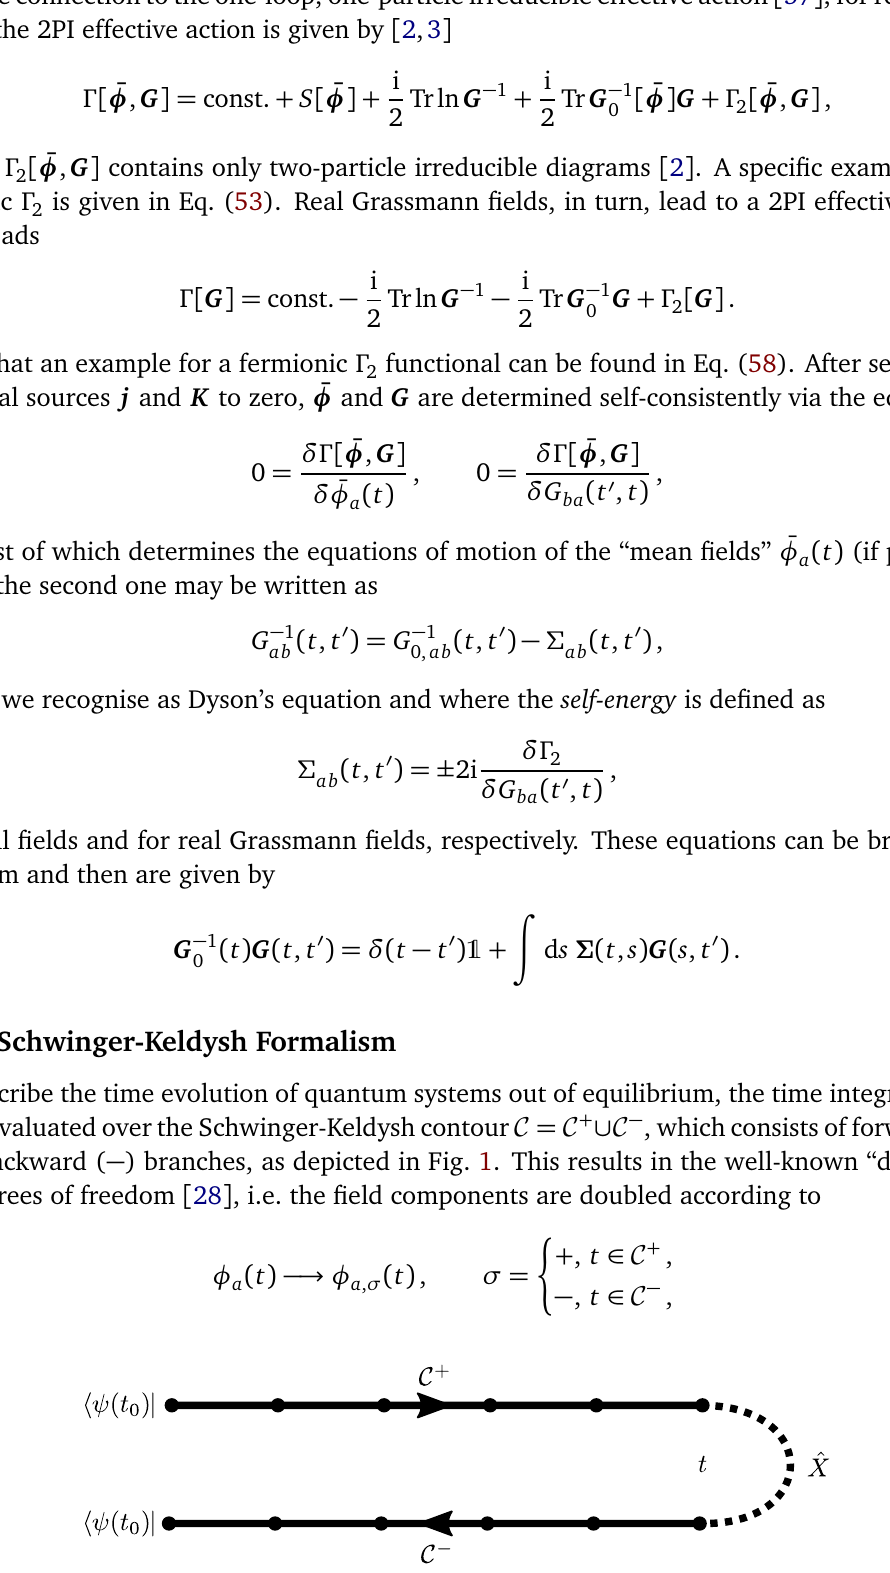
Figure 1: The Schwinger-Keldysh contour arises naturally when calculating time- dependent expectation